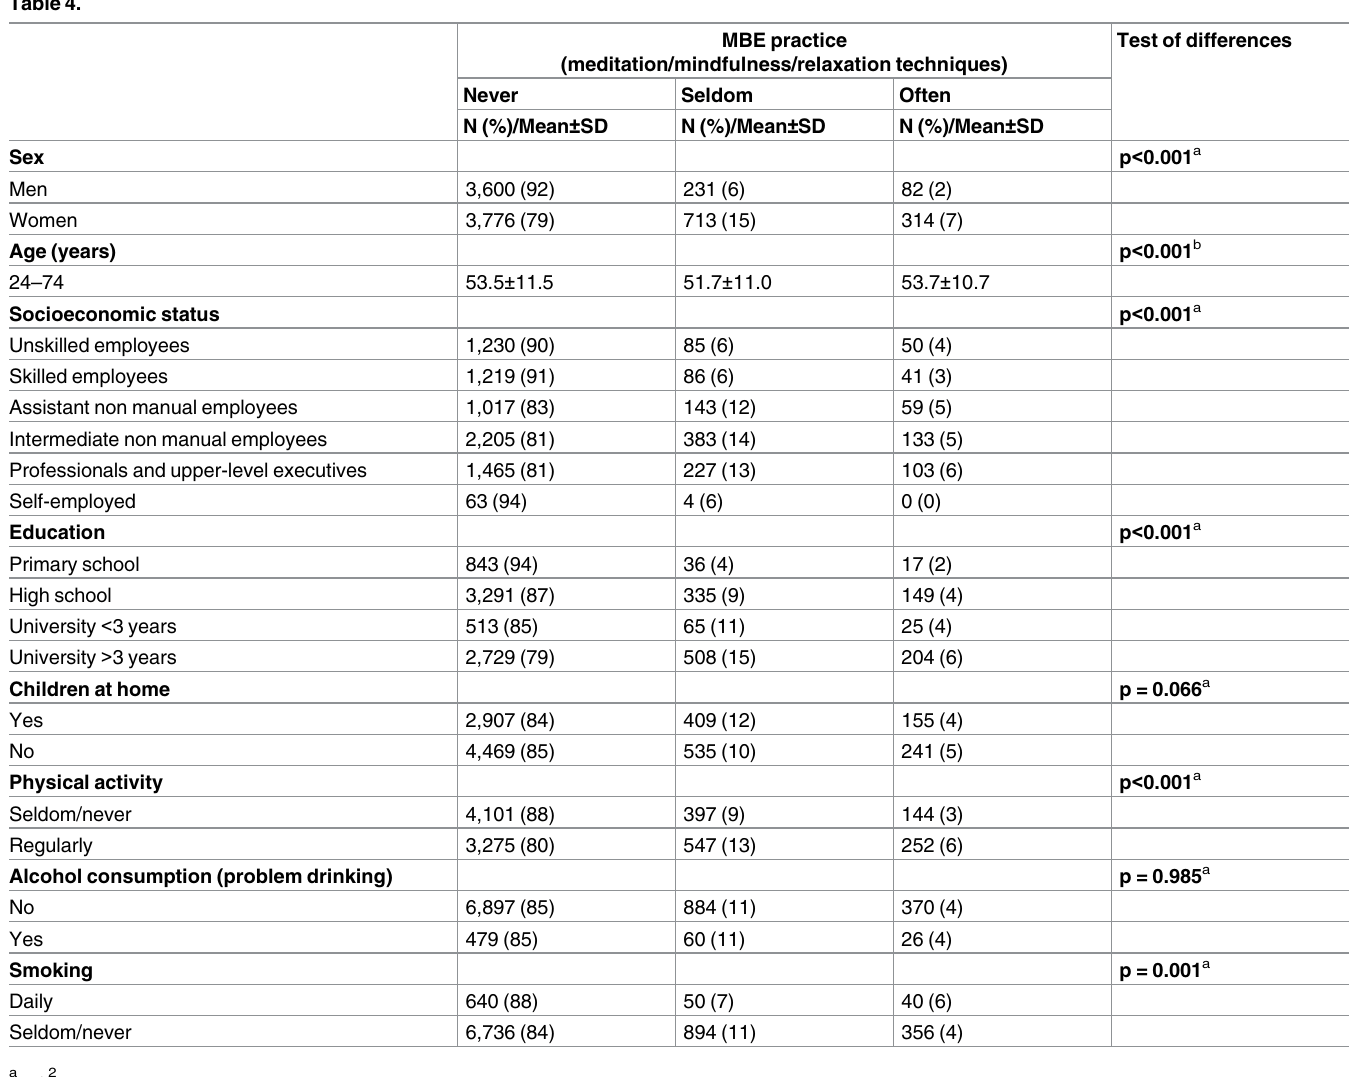
MBE practice (meditation/mindfulness/relaxation